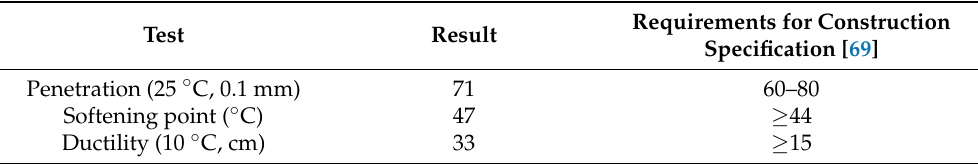
Table 2. Test results of 70# road